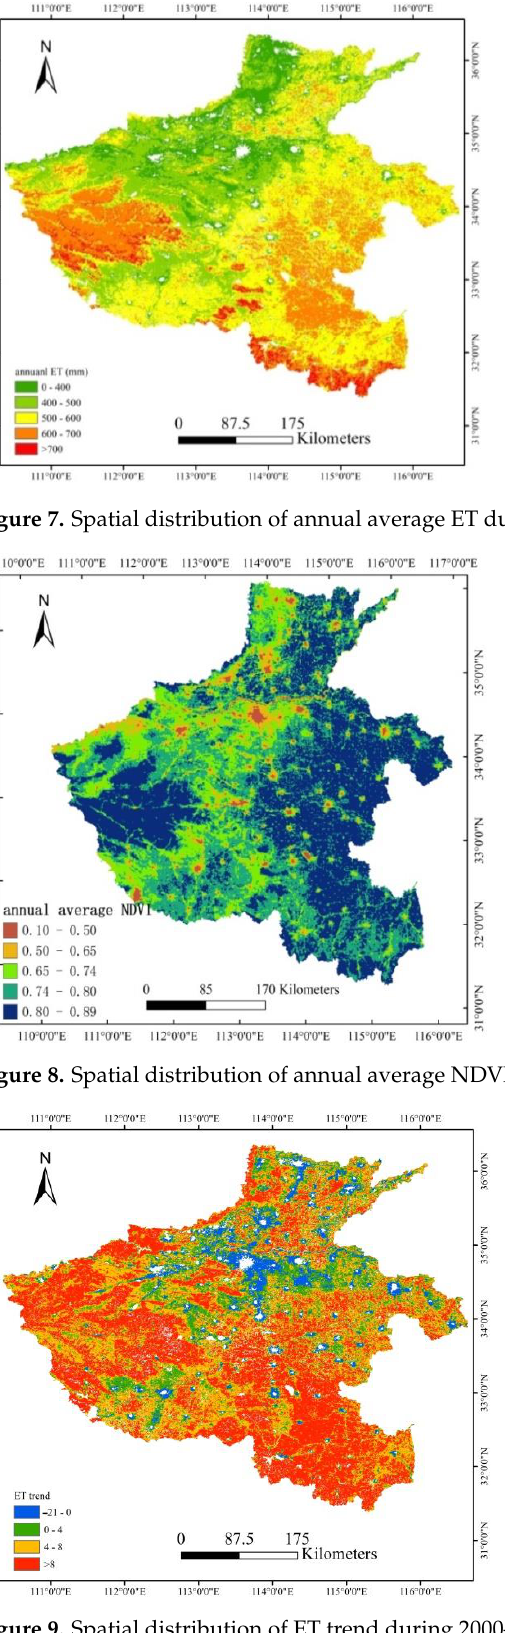
Figure 9. Spatial distribution of ET trend during 2000 – 2020.